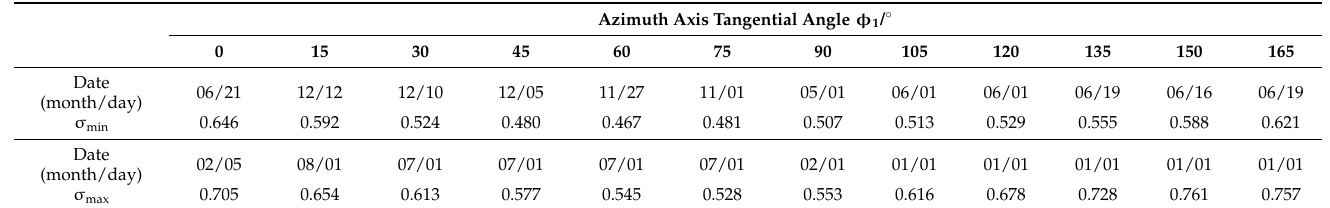
Table 3. Extreme values of effective tracking factors and corresponding dates for different tangential angles in a whole year operation cycle when the radial angle of azimuth axis is 0.1 ◦